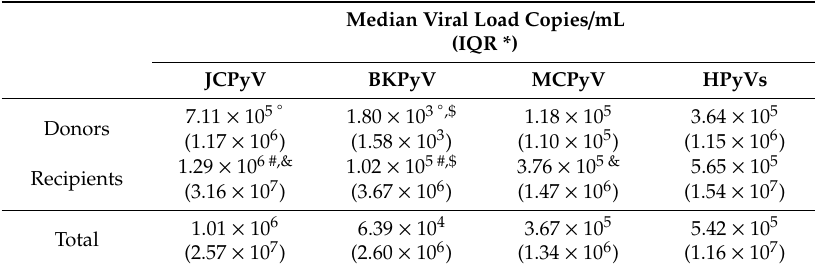
Table 5. HPyVs urinary loads in kidney transplant donors and recipients.